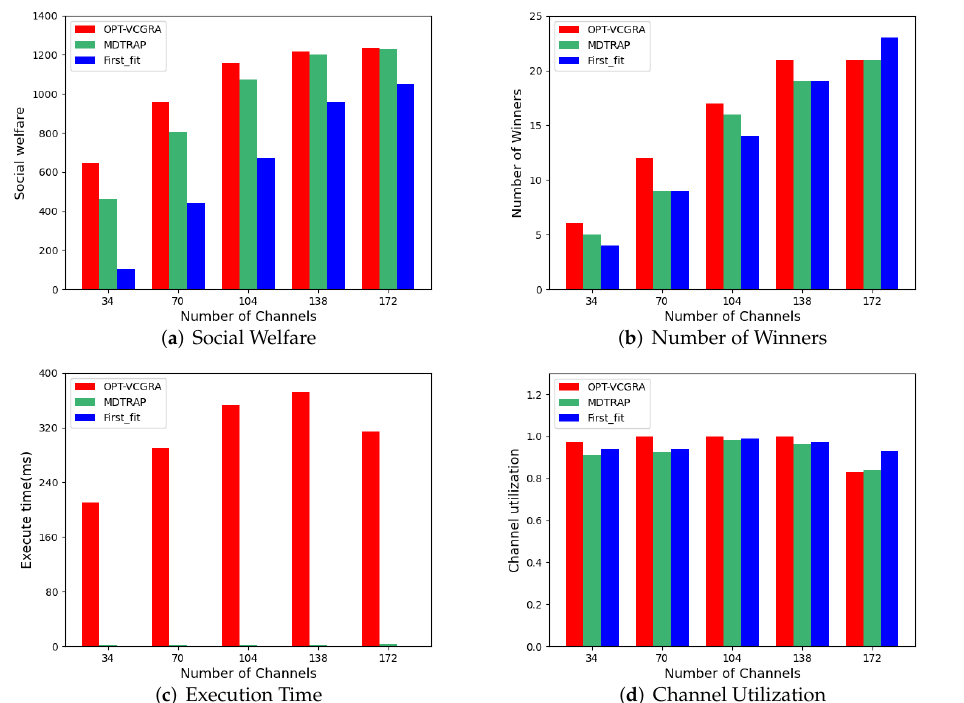
Figure 3. Social welfare, number of winners, algorithm execution time, and channel utilization under different numbers of